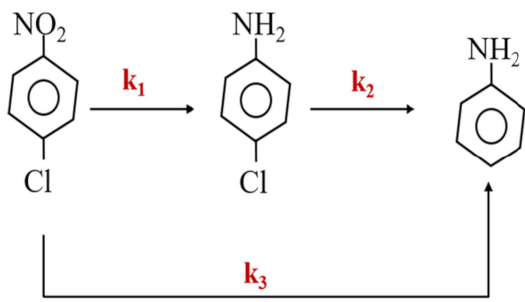
Figure 5. Pathway of p-CNB nitroreduction and dechlorination by ATP-nFe/Ni(k 1 , k 2 and k 3 denote the corresponding rate constants for the transformation of p-CNB, p-CAN and AN,